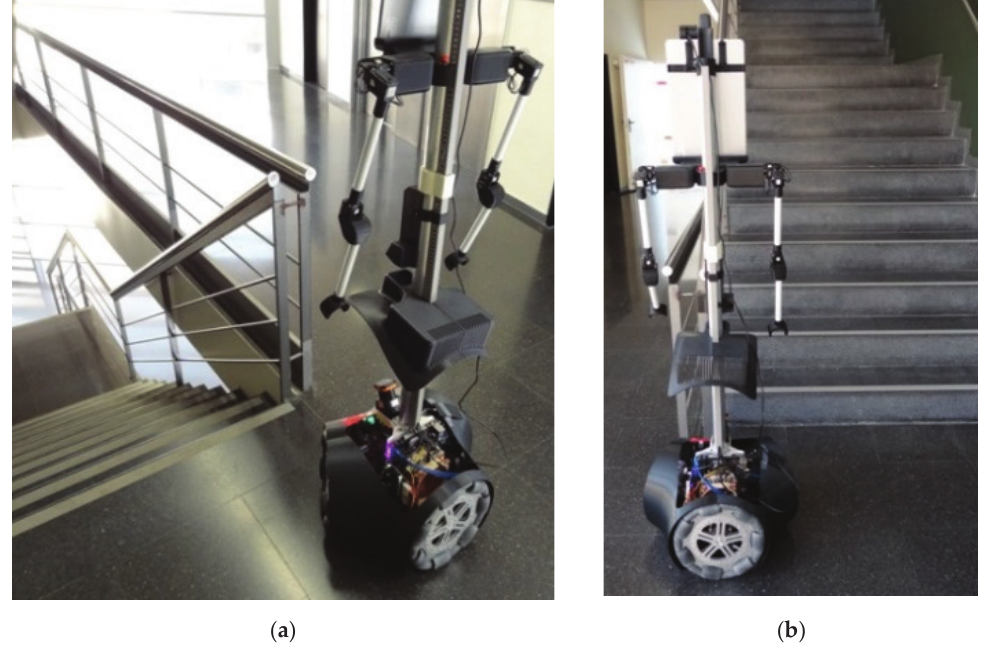
Figure 7. Mobile robot APR-03 placed in front of: ( a ) a stair going down and ( b ) a stair going up.